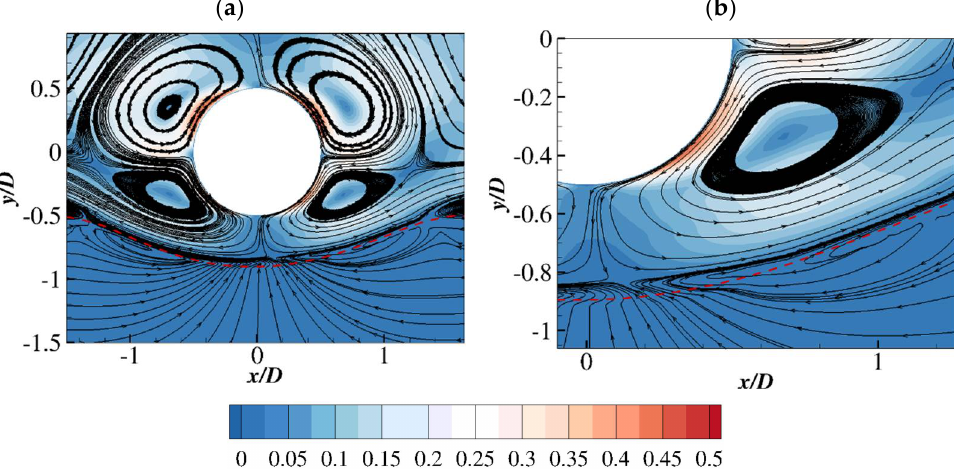
Figure 7. ( a ) The time-averaged fluid phase flow streamlines and the contours of the nondimensionalized magnitude of the velocity by U m for the single pipeline case and ( b ) a zoomed-in figure around the sediment profile. The dashed lines denote the iso-surface identified by φ = 0.5 .